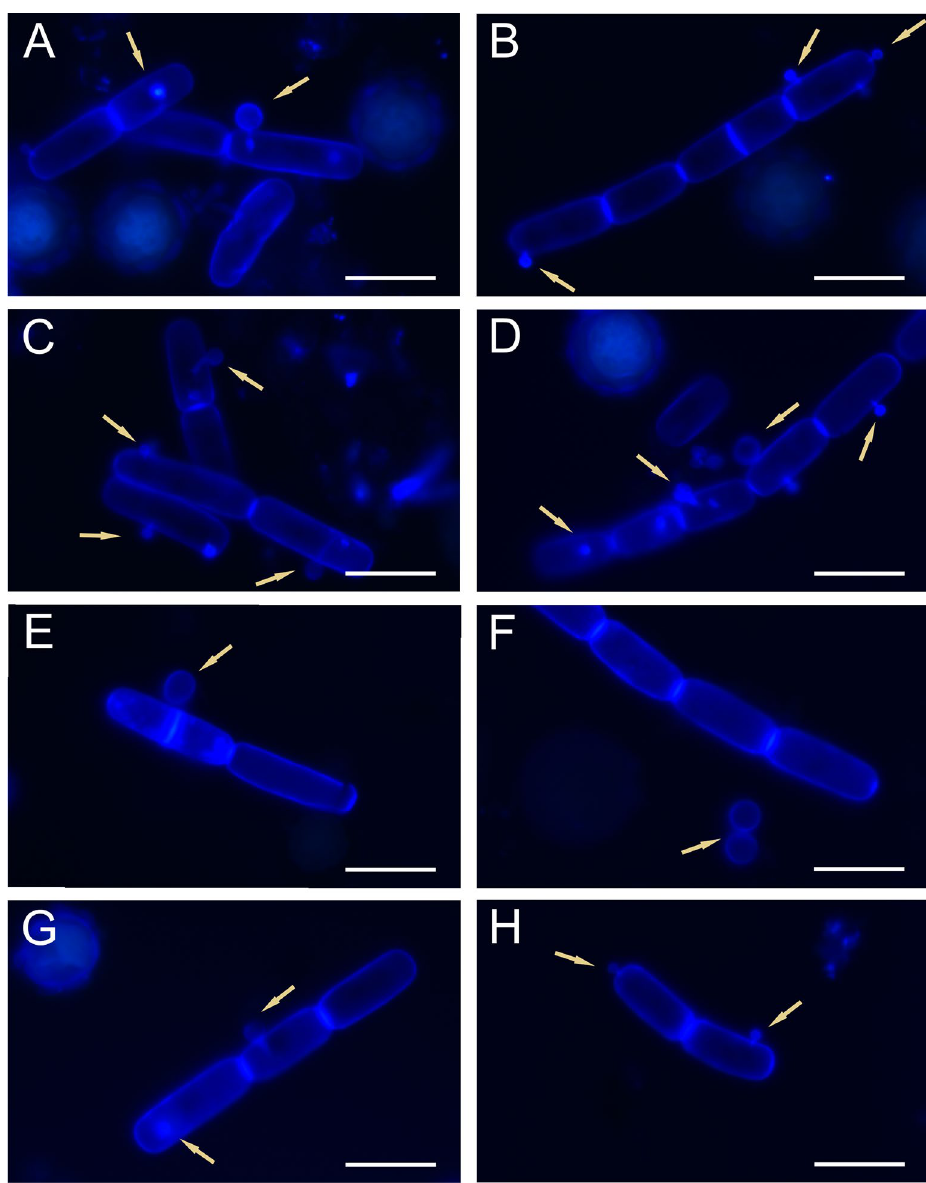
Figure 9. Microscopic images of S. nivaloides and A. nordenskioeldii cells from Upper Foxfonna Glacier (elevation 789 m) after staining with Calcofluor white. A–H— A. nordenskioeldii and parasitic fungus cells stained with Calcofluor white; fungal zoospores in various stages of development (marked with arrows). Images A–D, and G, H show glowing hypnozygotes. The scale bar corresponds to 20